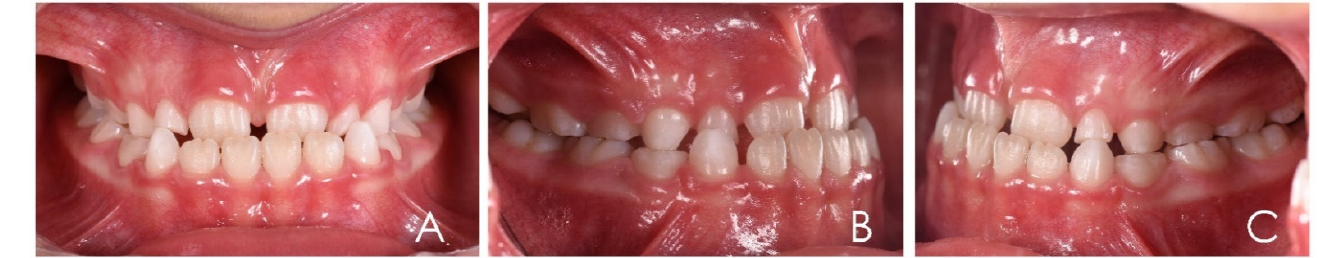
Figure 12. Intraoral photographs of the subject with skeletal class III malocclusion (7-year-old). ( A ) Frontal view; ( B , C ) lateral view.